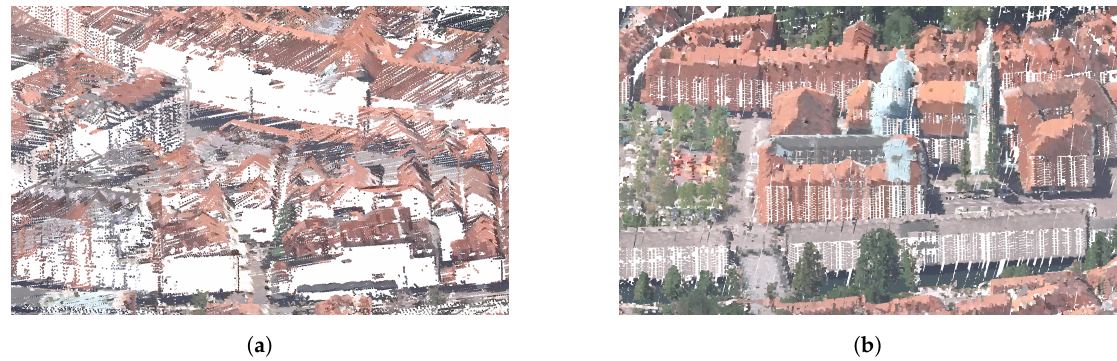
Figure 16. Building walls reconstruction examples for ( a ) bad cases, where the reconstruction fails, and ( b ) good cases, where reconstruction